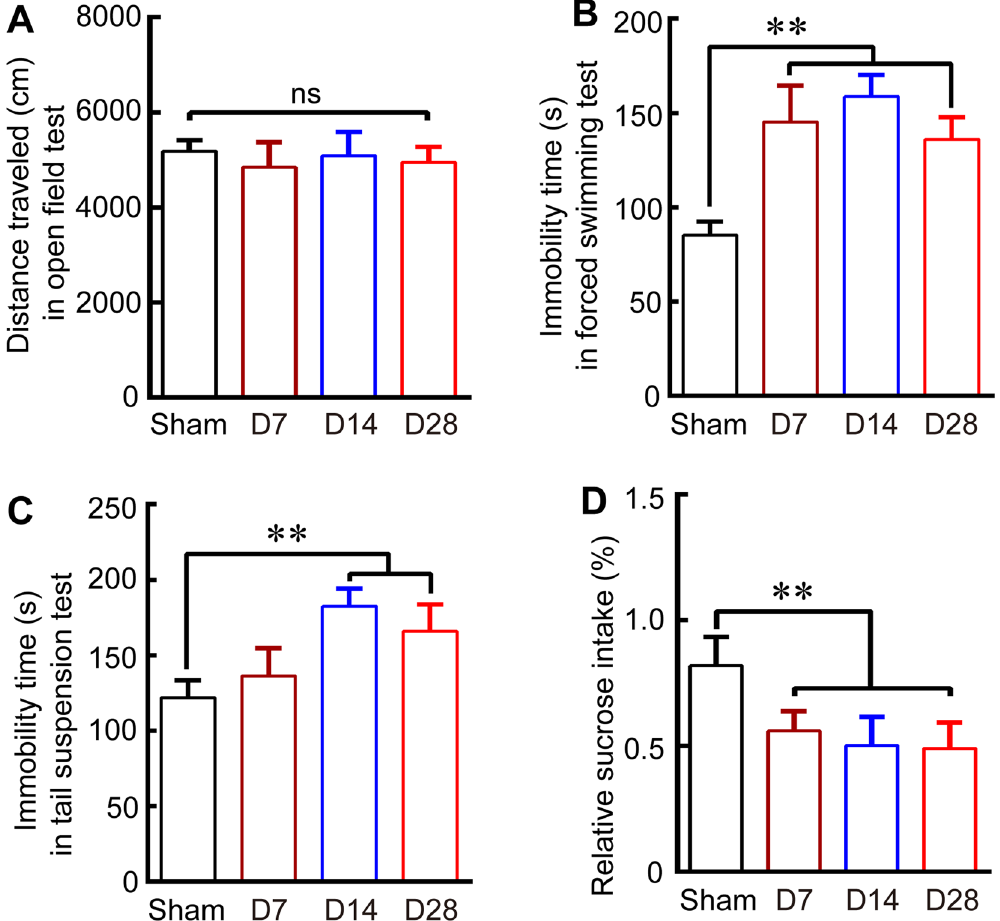
Figure 1. Depression-like behavior was detected after ICH in the sucrose preference test, forced swimming test (FST) and tail suspension test (TST). ( A ) Quantitative data for total distance travelled in the open-field test over a period of 10 min at 7, 14 and 28 days after ICH. ( B - C ) Quantitative data for immobility time(s) in the FST (A) and TST (B) in mice in the sham group and at 7, 14, and 28 days post-ICH. ( D ) Quantitative data for relative sucrose intake (%) in the sham group and at 7, 14, and 28 days post-ICH. Data are shown as the means ± SEM (at least n = 8 for the behavior tests in each group; ** P < 0.01 versus the Sham group; ns = not